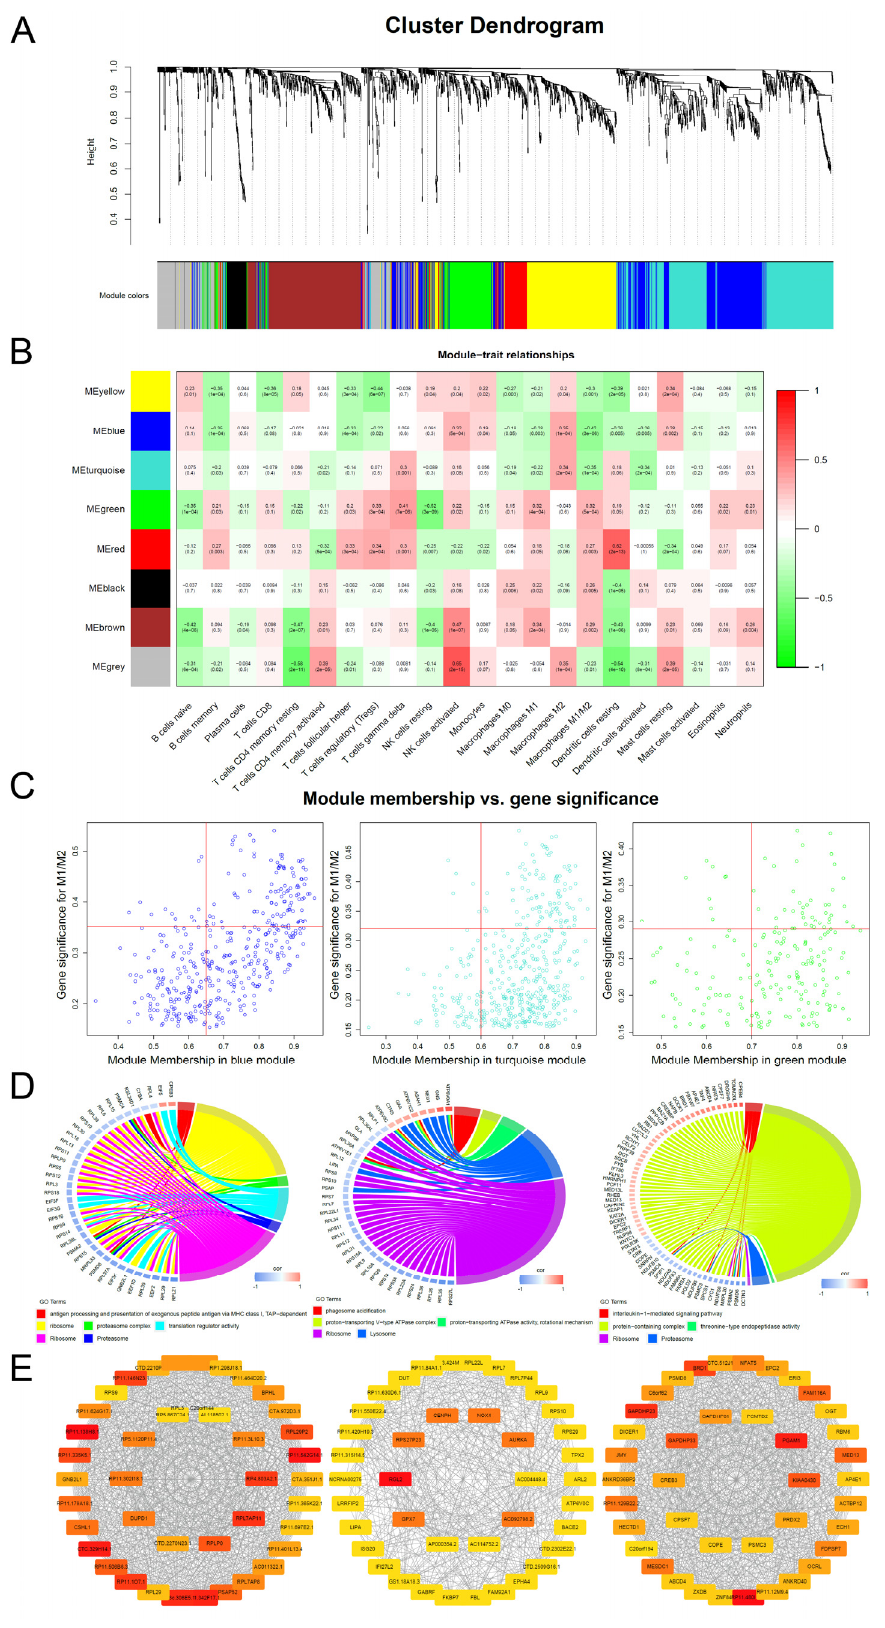
Figure 3. M1/M2 related WGCNA and module enrichment analyses. ( A ) Visual representations of the gene co-expression network. Hierarchical clustering of 2185 genes and visualization of gene module partitioning. Coloured bars (below) directly correspond to module (colour) designation for